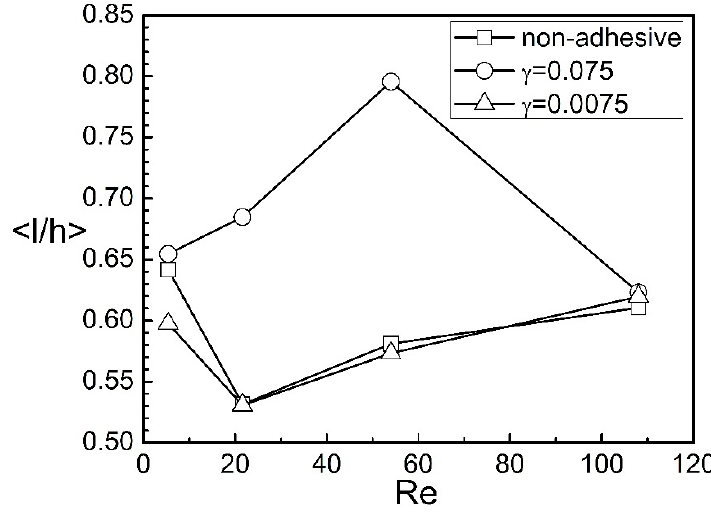
Figure 22. The average lateral position as a function of Reynolds number.